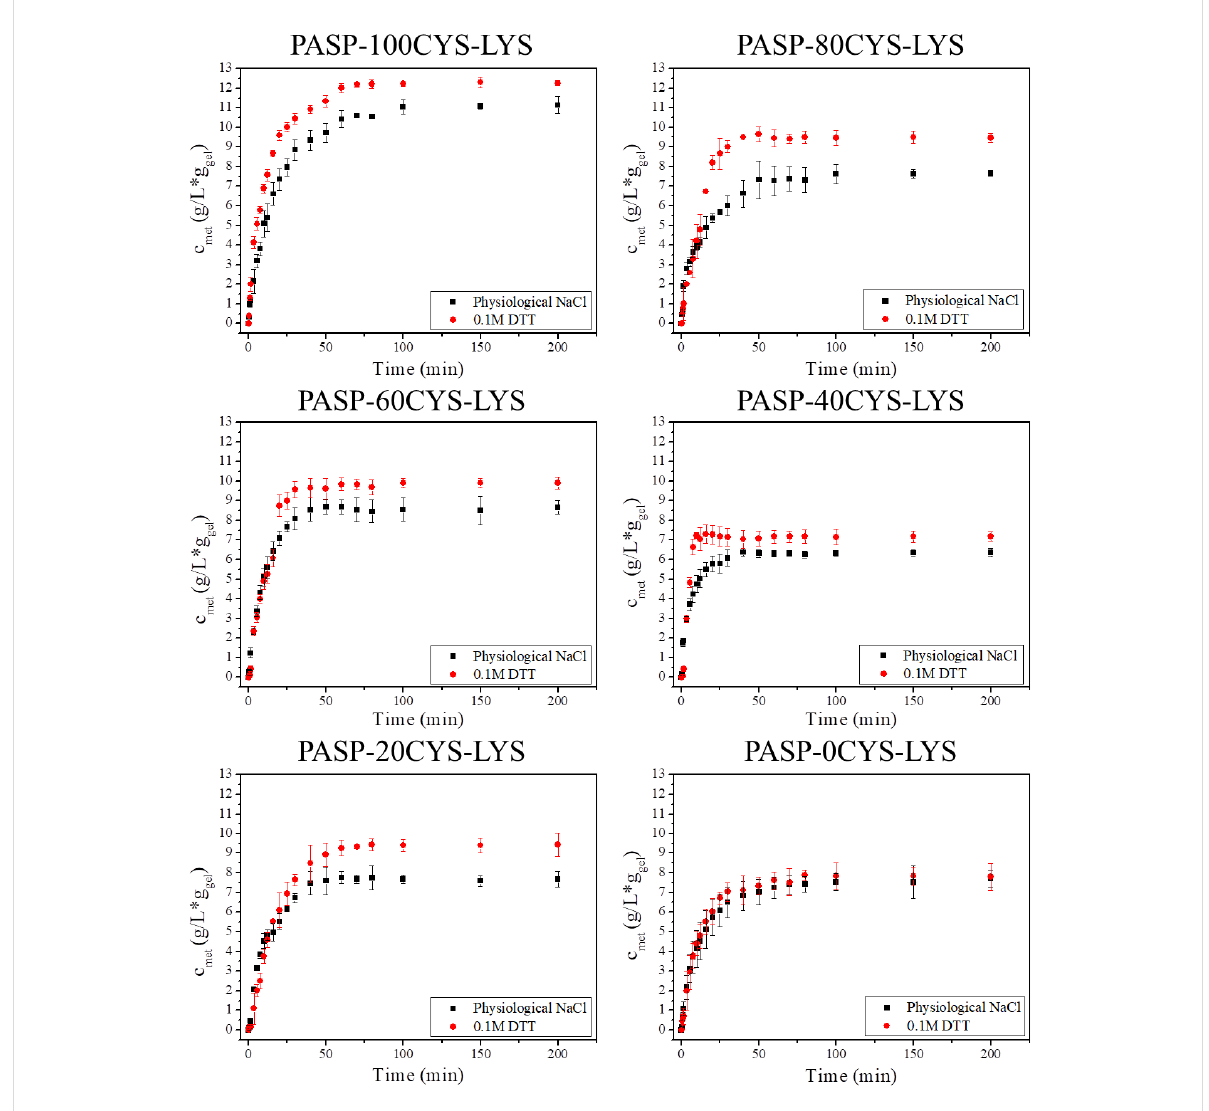
Figure 7: Metoprolol release from the different PASP-XCYS-LYS gels ( c met ) in physiological saline solution (black squares) and in 0.1 M DTT/physio- logical saline solution (red circles).